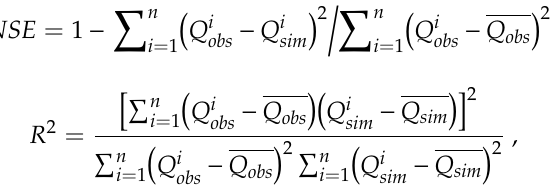
Table 1. Forest biomass per hectare and proportional species composition of the two forest types in the four periods. Needleleaf Forest Broadleaf Deciduous Forest (Larch-Dominated) (Birch-Dominated) Period Mid-Year Biomass (t / ha) Area